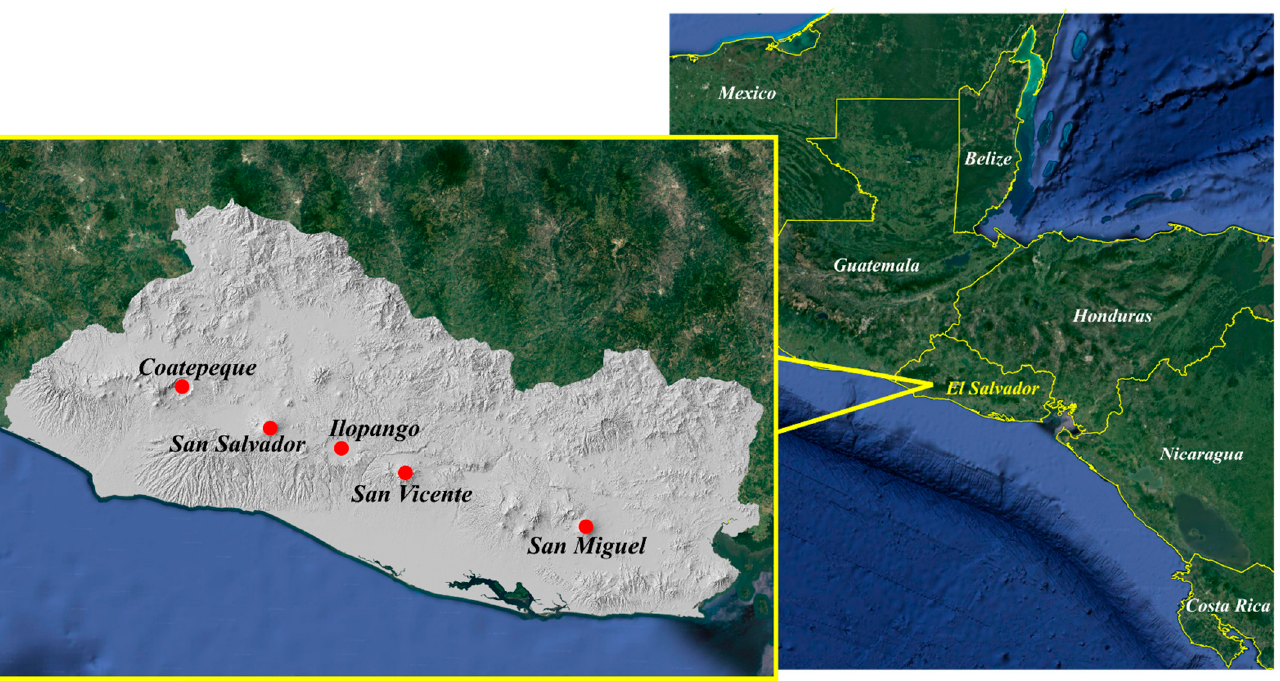
Figure 1. Setting of the study area.